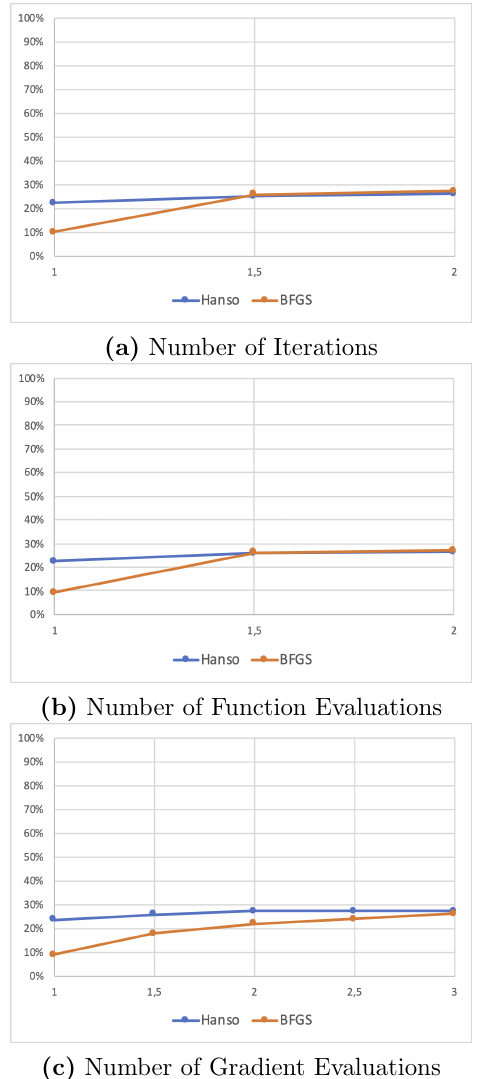
Figure 2. Performance Profiles for Non-convex